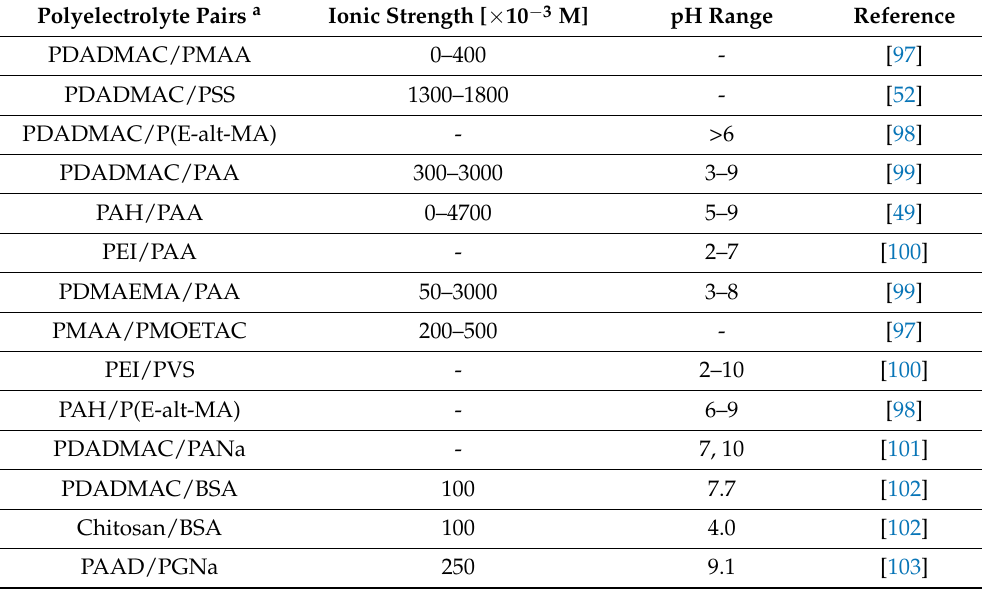
Table 2. The formation of coacervates by representative oppositely charged polyelectrolyte pairs and corresponding formation conditions.